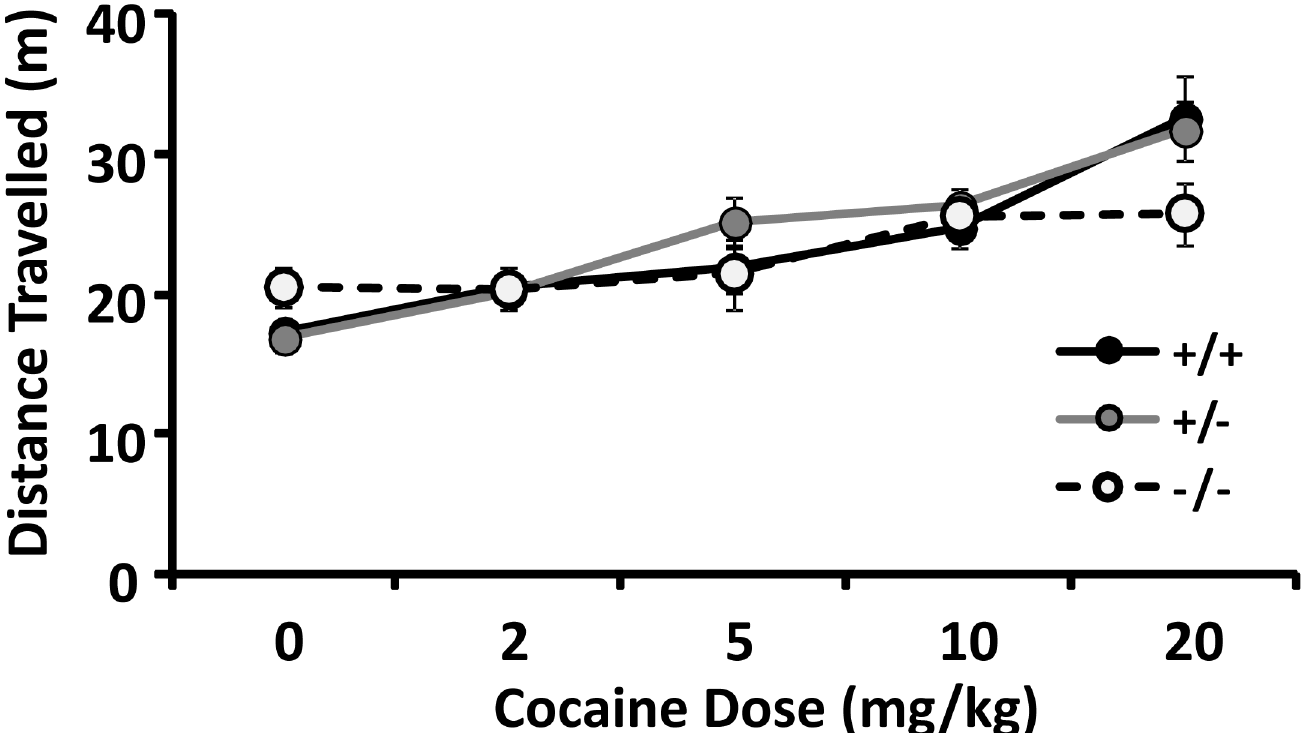
Fig 5. CSMD1 knockouts display differences in locomotion during the 20 min conditioning sessions when confined to 20 x 20 cm portions of the conditioned place preference boxes after receiving their first saline or cocaine injections. Saline-injected CSMD1 knockouts displayed significantly increased locomotion (p = 0.002) in comparison to mice of other genotypes. Significant effects of cocaine dose and gender were identified in ANCOVA of data from cocaine-injected mice of all genotypes (p = 5.5 x 10 − 15 and 0.009, respectively). There was a trend towards genotype * dose interaction (p = 0.054). Values are mean +/- SEM of the number of m